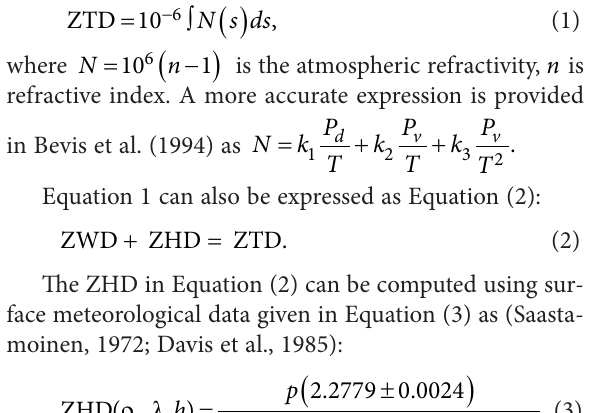
Figure 2. Köppen-Geiger climate classification for Nigeria; 1980–2016 (Beck et al., Tropical Monsoon (Am) around Edo, Enugu, Imo, Abia and Cross River; Tropical Savannah (Aw) around North- Central and South-West geopolitical zones; Arid Desert hot (BWh) around some part of North-East geopolitical zone; Arid Steppe hot (BSh) around the North-West geo- political zone.